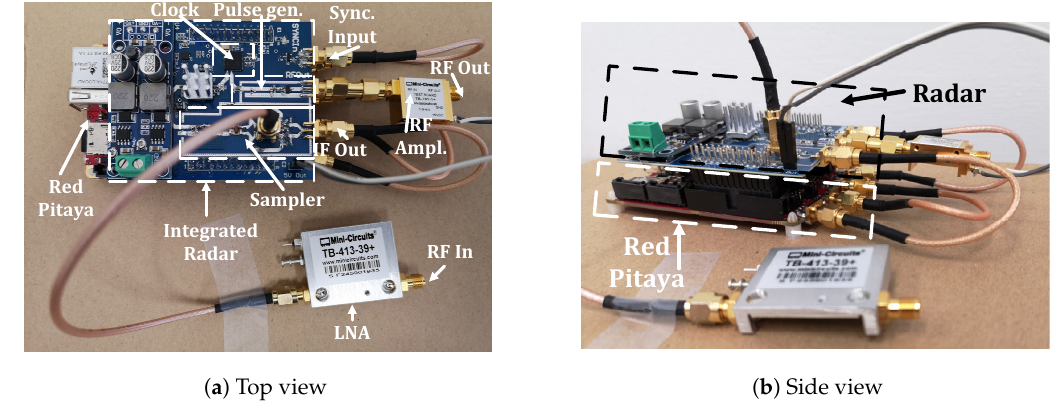
Figure 12. Picture of the proposed radar attached on the Red Pitaya